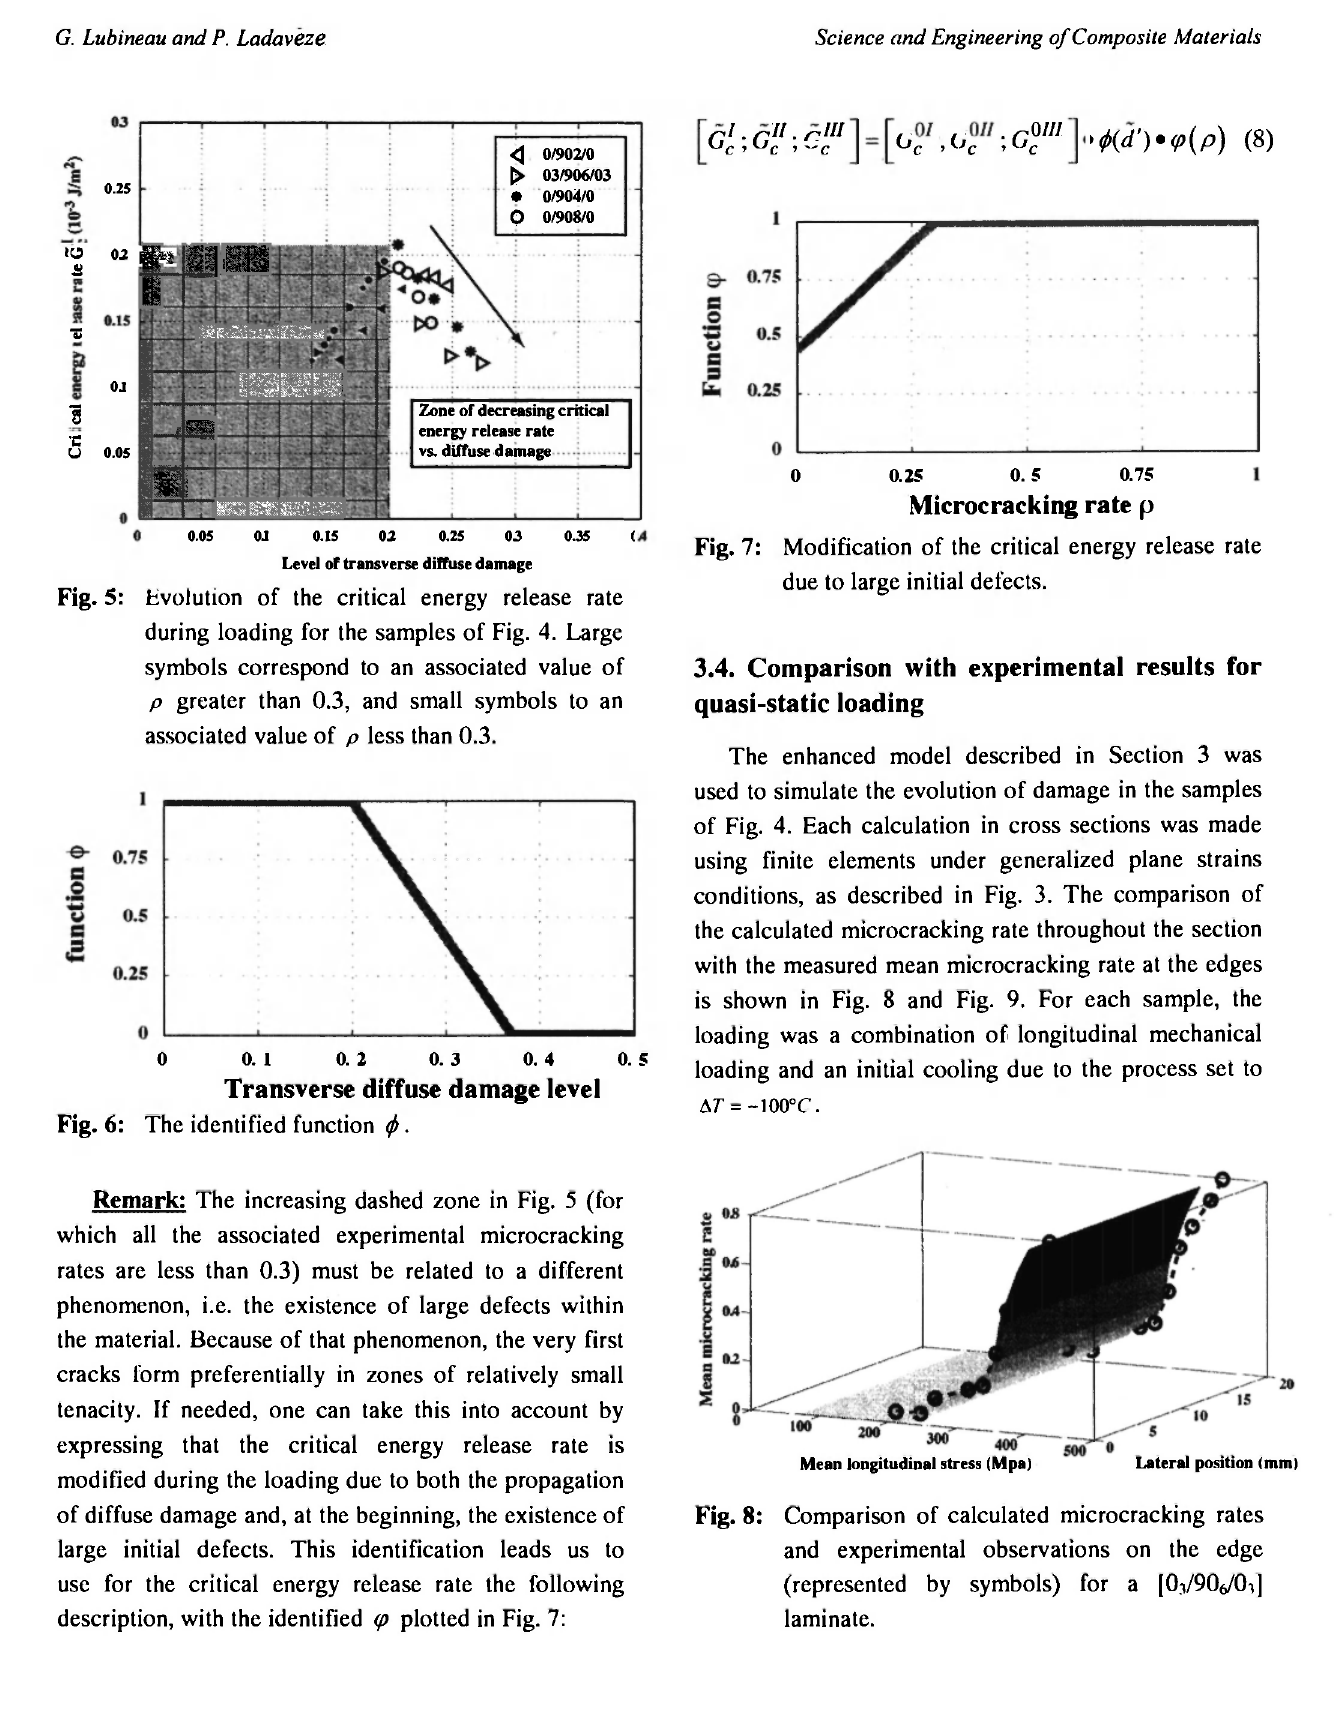
Fig. 8: Comparison of calculated microcracking rates and experimental observations on the edge (represented by symbols) for a [O^VO·,]